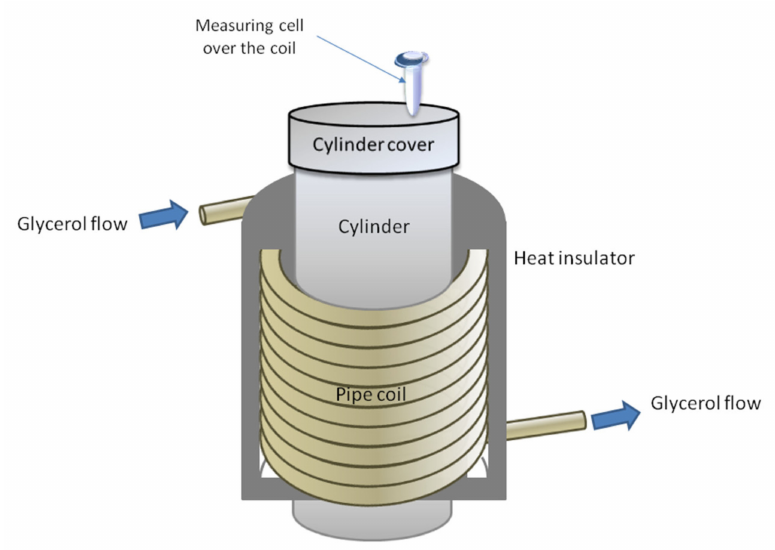
Figure 1. Experimental setup for studying the influence of glycerol flow through a coiled communication pipe on the physicochemical properties of horseradish peroxidase (HRP). The measuring cell was placed over the